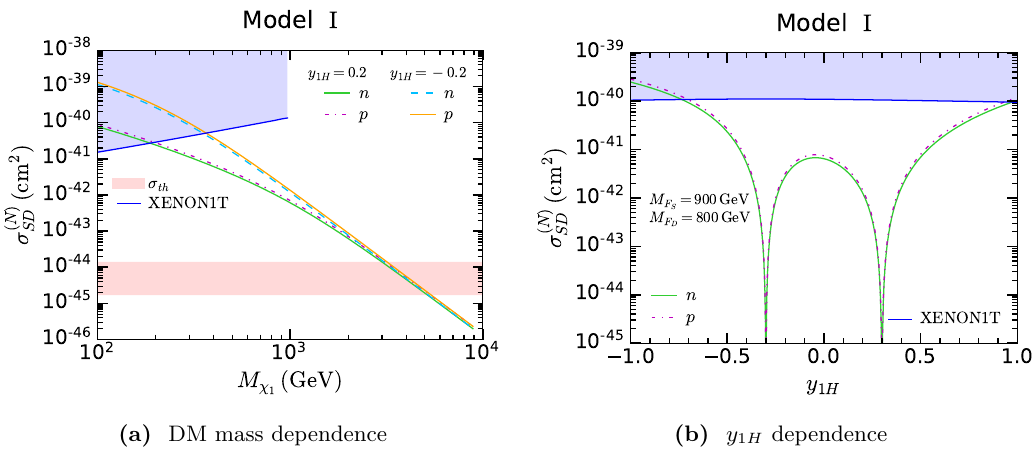
Figure 8. The DM-nucleon SD scattering cross sections as functions of (a) the DM mass M χ (b) y 1 H . The rest of the parameters are fixed as in figure 6. The blue shaded area is excluded by the XENON1T experiment [173]. The horizontal red band represents the threshold cross section for neutron obtained in refs. [128,